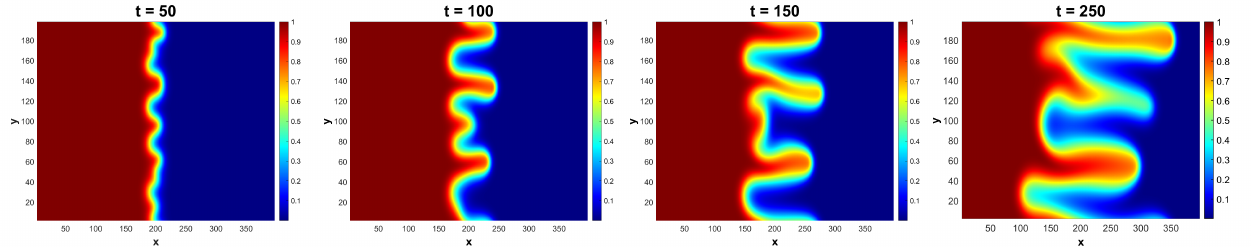
Figure 7. (Numerical Test 3) Snapshots of flow data at different four time instances.